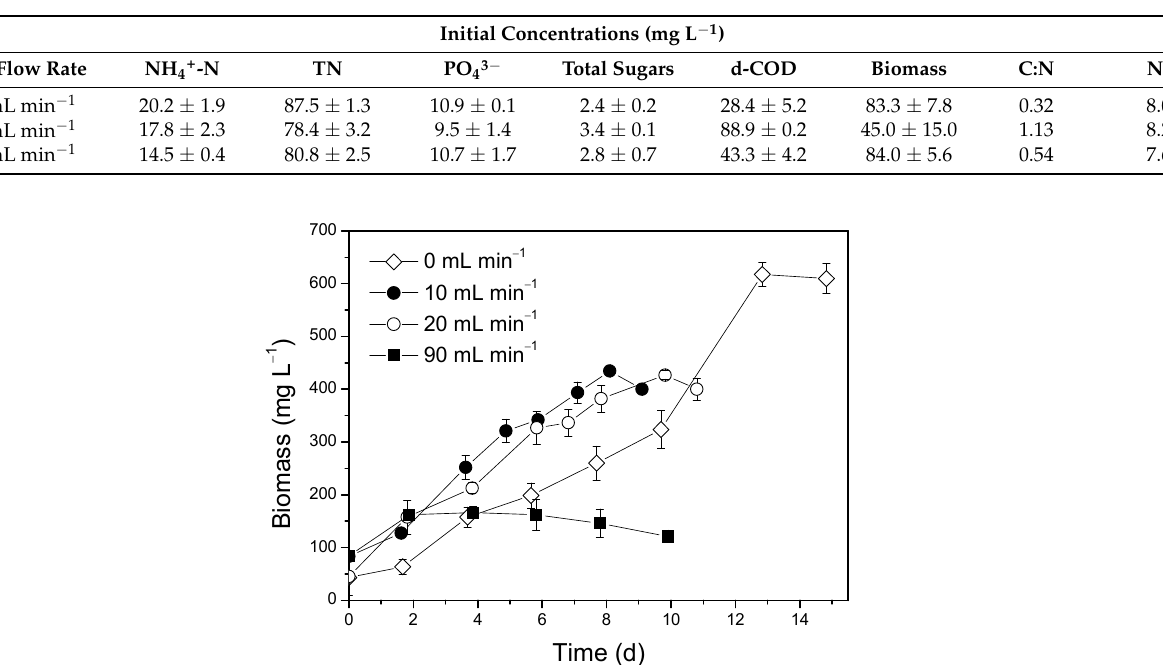
Table 14. Nutrient reduction rates, biomass productivity and specific growth rates in the experi ‐ mental sets using pure CO 2 as carbon source. Table 13. Initial biomass and nutrient concentrations in the experimental sets using pure CO 2 as carbon source.